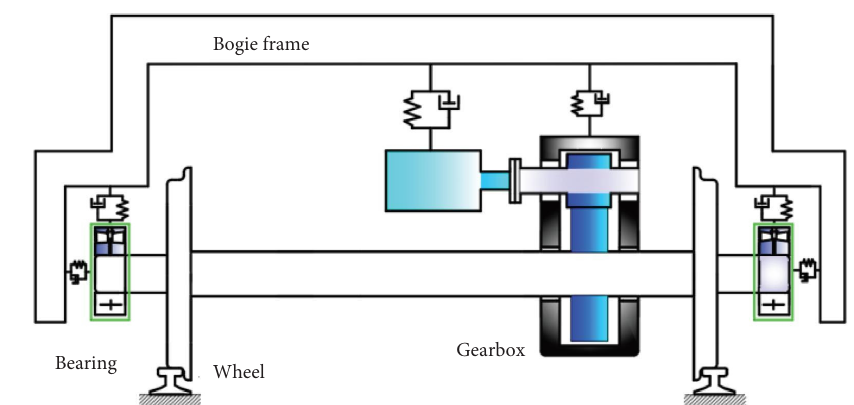
Figure 1: High-speed train transmission system.